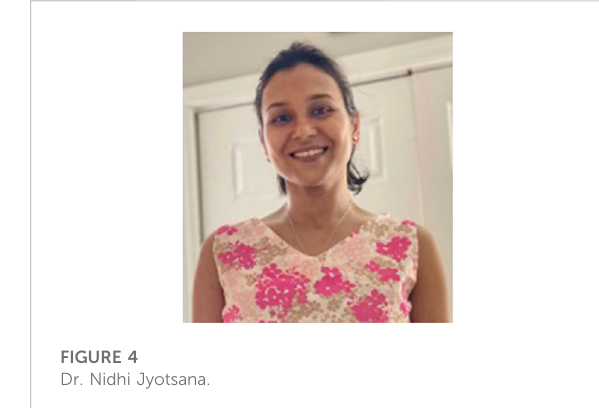
FIGURE 4 Dr. Nidhi